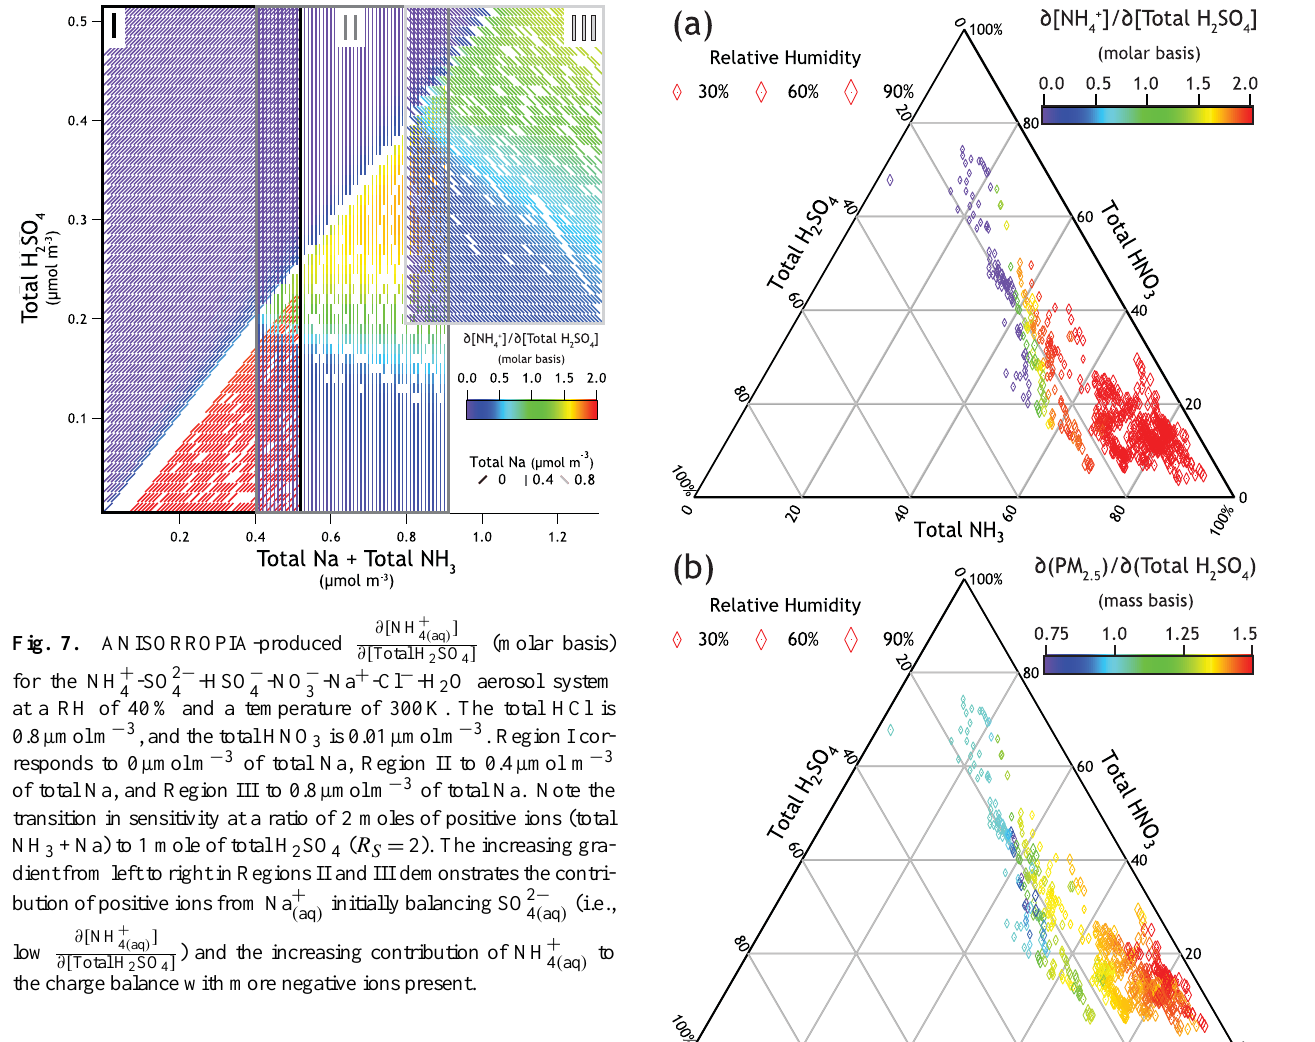
∂( PM 2 . 5 , dry ) (mass ba- ∂( TotalH 2 SO 4 )